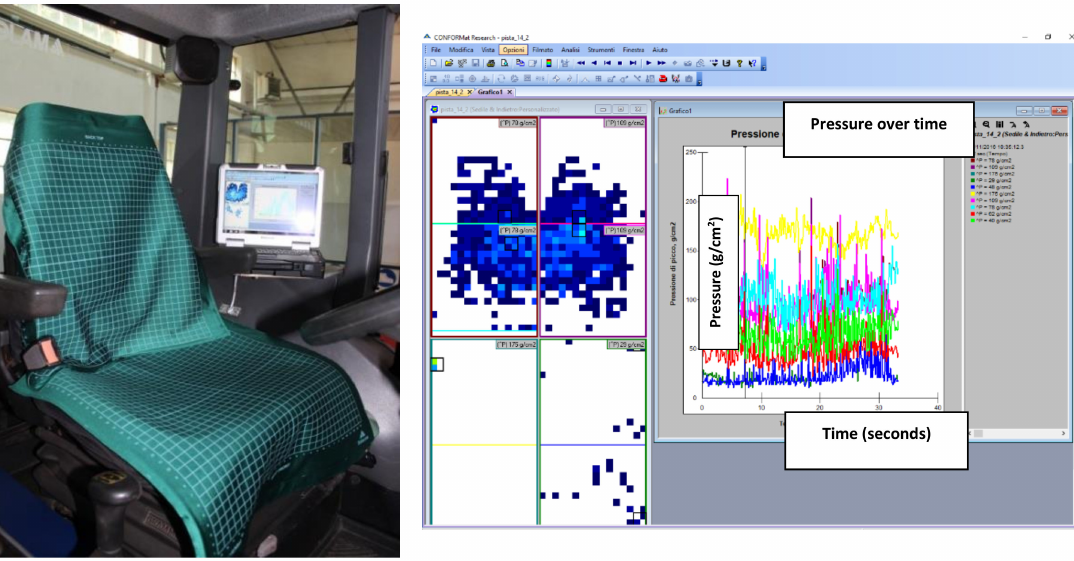
Figure 5. Sensor mat for barometric measurements (CONFORMat Seat) ( left ); a picture of the acquired signal after one test ( right